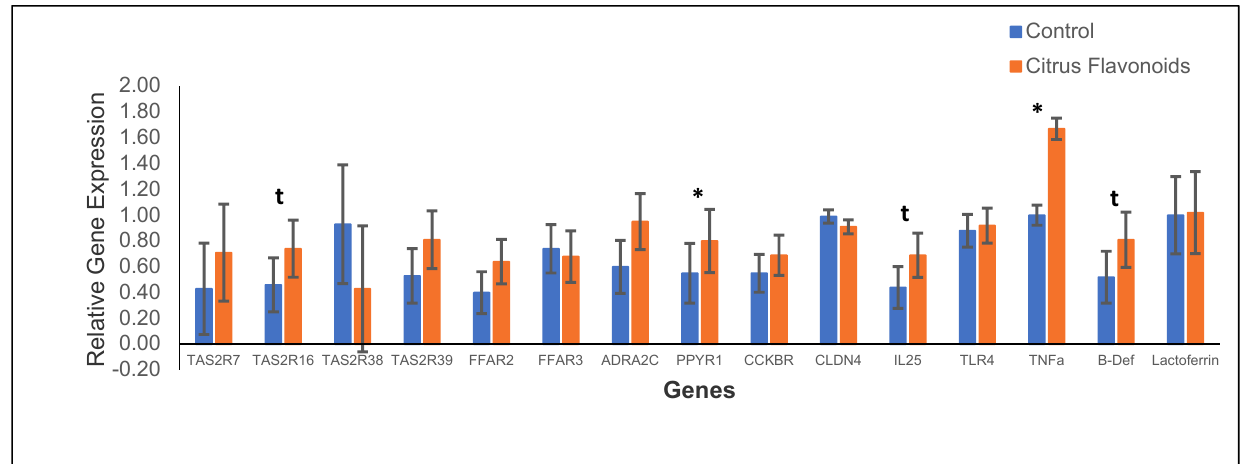
Figure 3. Gene expression in rumen epithelium of Holstein bulls fed high-concentrate diets with or without citrus flavonoids supplementation (* = p < 0.05 and t = 0.05 ≤ p ≤ 0.10). TAS2R7: Bitter taste receptor 7; TAS2R16: Bitter taste receptor 16; TAS2R38: Bitter taste receptor 38; TAS2R39: Bitter taste receptor 39; FFAR2: Free fatty acid receptor 3 (gpr41); FFAR3: Free fatty acid receptor 2 (gpr43); ADRA2C: Alpha 2-adrenergic receptors subtype C; PPYR1: Pancreatic polypeptide receptor 1; CCKBR: Cholecystokinin receptor 4; IL-25: I nterleukin-25; TLR4: Pattern recognition receptors, like Toll-like receptor 4; TNFa: Tumor necro- sis factor alpha; B-Def: Beta-defensin. The values presented herein correspond to back-transformed means; however, SEM corresponds to the ANOVA analyses using log-transformed data.